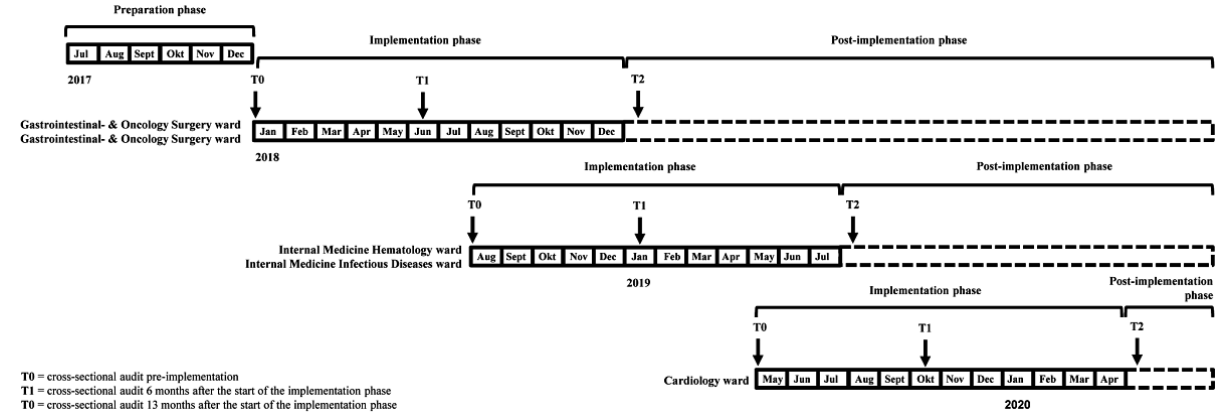
Figure 1. Project